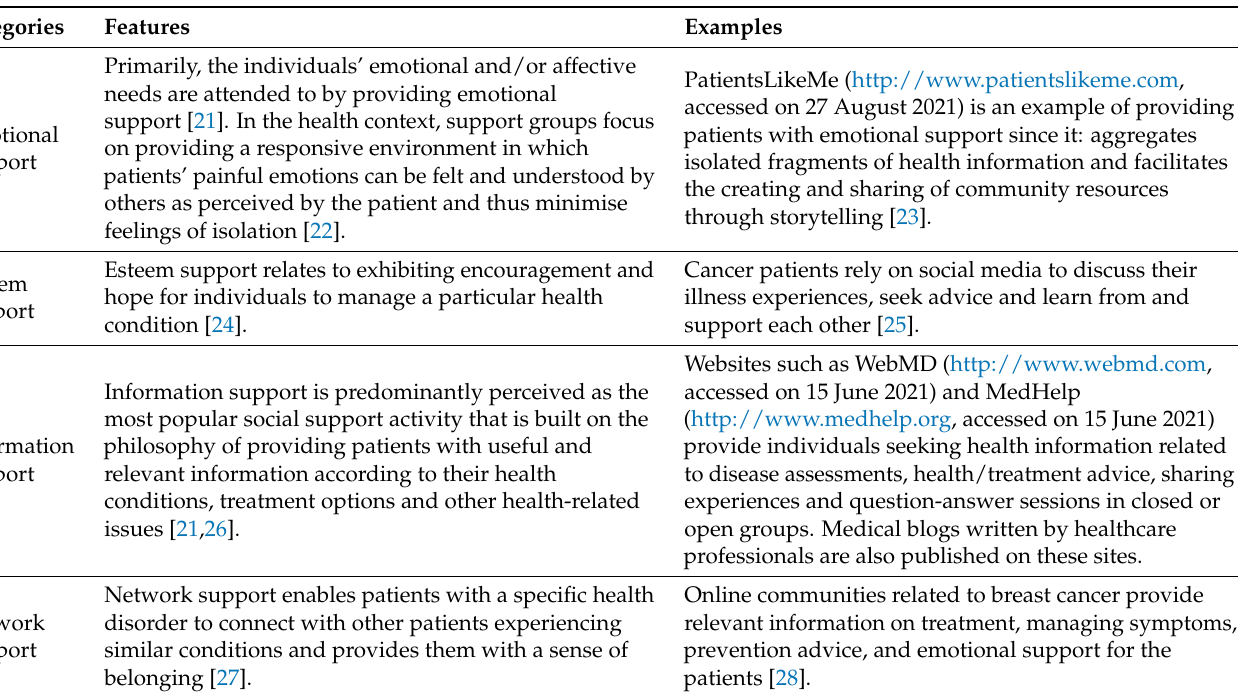
Table 1. Categories of social